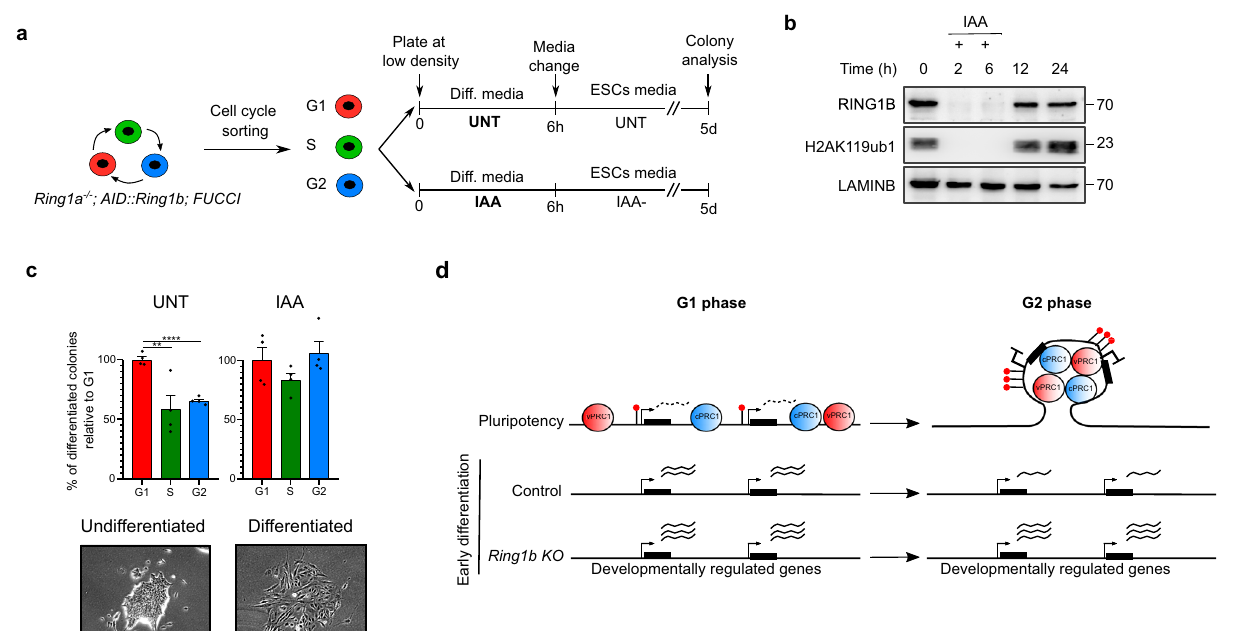
Fig. 7 | Depletion of RING1B interferes with cell-cycle-phase-dependent ability of mESCs to differentiate. a Scheme showing the experimental design to study the cell-cycle-phase-speci fi c role of RING1B in productive cell differentiation. Ring1a − / − ;AID:: Ring1b ;FUCCImESCswerecellcyclesortedandplatedatlowdensity indifferentiationmedia(0.1 µ MRAintheabsenceofLIF)with(RING1B-depleted)or without (control UNT) auxin (IAA). After 6h cells were cultured in standard ESCs media and colonies were fi xed and analyzed after fi ve days. b Western blots of whole cell extracts for RING1B and H2AK119ub1 proteins in Ring1a − / − ;AID:: Ring1b ; - FUCCImESCstreatedwithIAAfortheindicatedtimes.LaminBwasusedasloading control.MolecularweightisindicatedinkDa.Twobiologicalreplicateswerecarried out. c Histograms showing the percentage of differentiated colonies relative to G1 obtained after fi ve days from cell cycle sorted populations in parental control (UNT) and IAA-treated (RING1B-depleted) cells (see experimental setup in Fig. 6h). Pictures showing examples of colonies with undifferentiated (compact and 3D